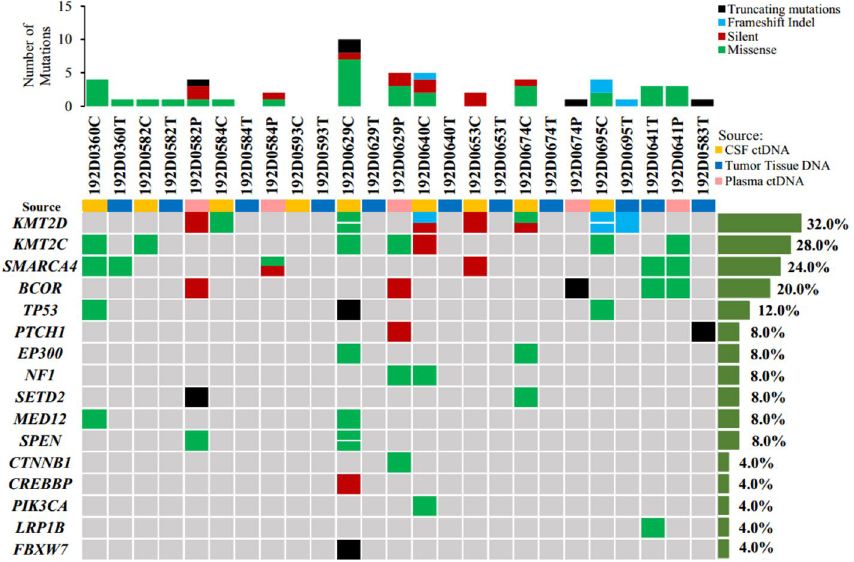
Figure 1. The genomic landscape of 11 medulloblastoma patients. Top, frequency of mutations per case; Bottom left, genetic alterations detected in 16 medulloblastoma-associated genes; Bottom right, frequency of mutations per gene in three different types of samples. C, CSF supernatant; T, tumor tissue; P, plasma.